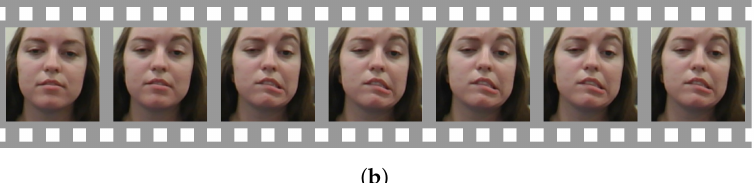
Figure 8. False negative example with significantly different facial motion intensity. Subject considers ( a , b ) as the same motion. Beside the intensity change on lips, ( b ) also has the left eye always opened.